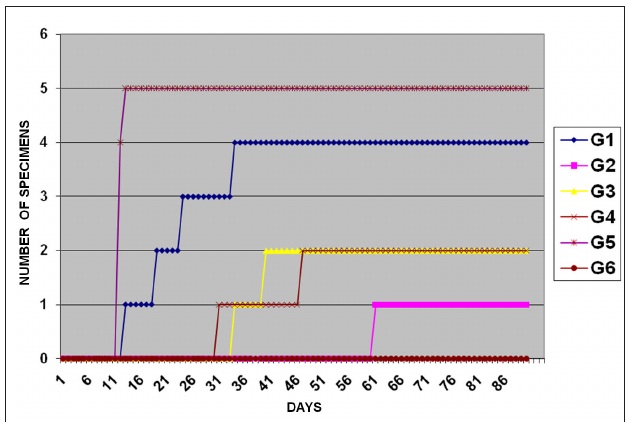
Fig. 1- Number of teeth contaminated at 90